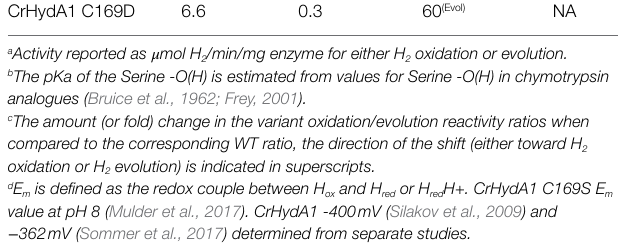
Evolution Reactivity